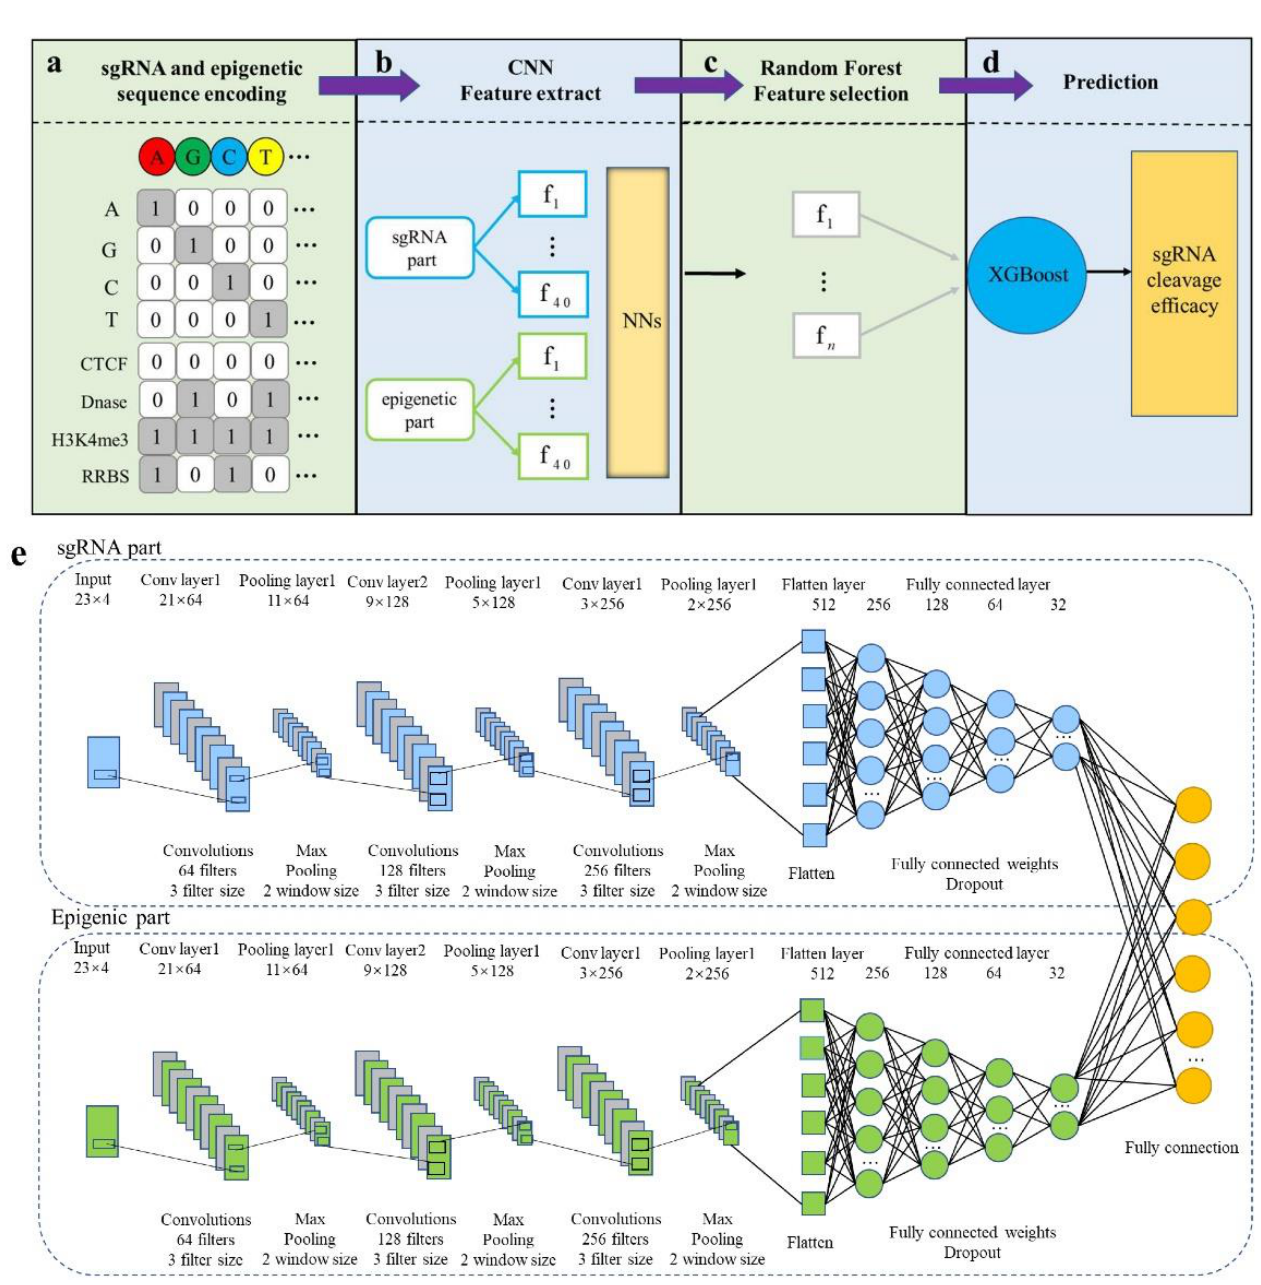
Figure 1. Implementation details of CNN-XG. ( a ) sgRNA and epigenetic information sequence encoding schema. There are four bases in nucleotides, A, G, C and T, each of which is seen as a channel, and each piece of epigenetic information is also seen as a channel. ( b ) Training and feature extraction in CNN. ( c ) The features extracted by the CNN are further selected using random forest models. ( d ) The selected features are put into the XGBoost classifier for the final prediction. ( e ) The structure of the convolutional part. The network contains two structurally identical branches for extracting sgRNA and epigenetic features. The final fully connected layer is used to obtain the final output.